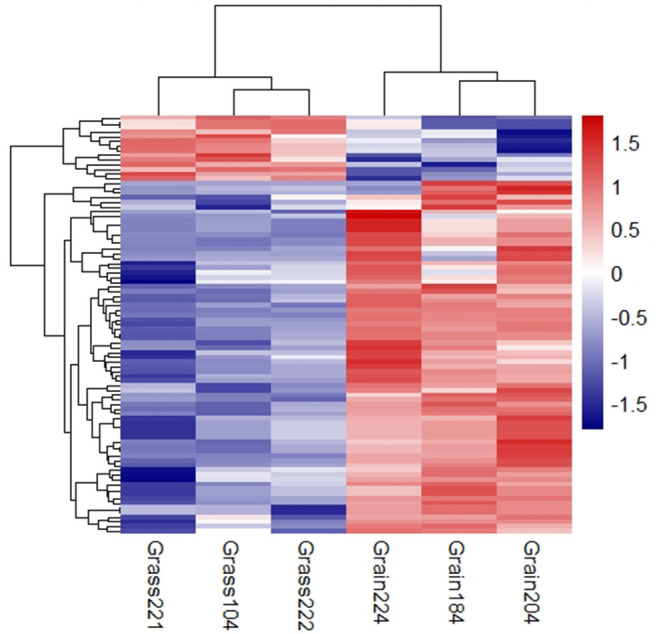
Cluster analysis of differential expression miRNAs in grass-fed vs. grain-fed. On the top-right of the figure, the color difference represents the relative abundance.